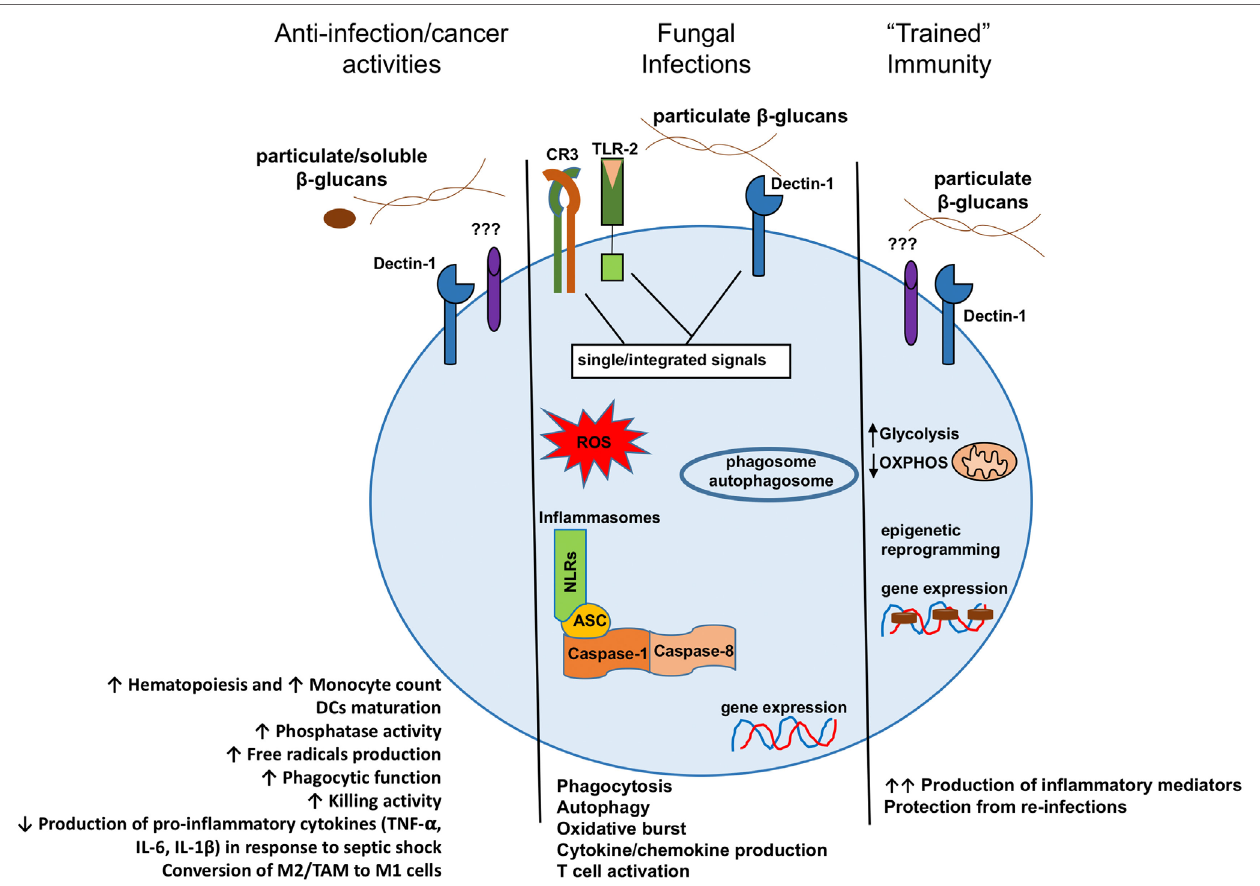
FiGURe 1 | Model presenting the different consequences of β -glucan recognition by mononuclear phagocytes in the context of antitumoral activities, fungal infection recognitions, or trained immunity. DCs, dendritic cells; M2, alternative macrophages; TAM, tumor-associated macrophages; M1, classical